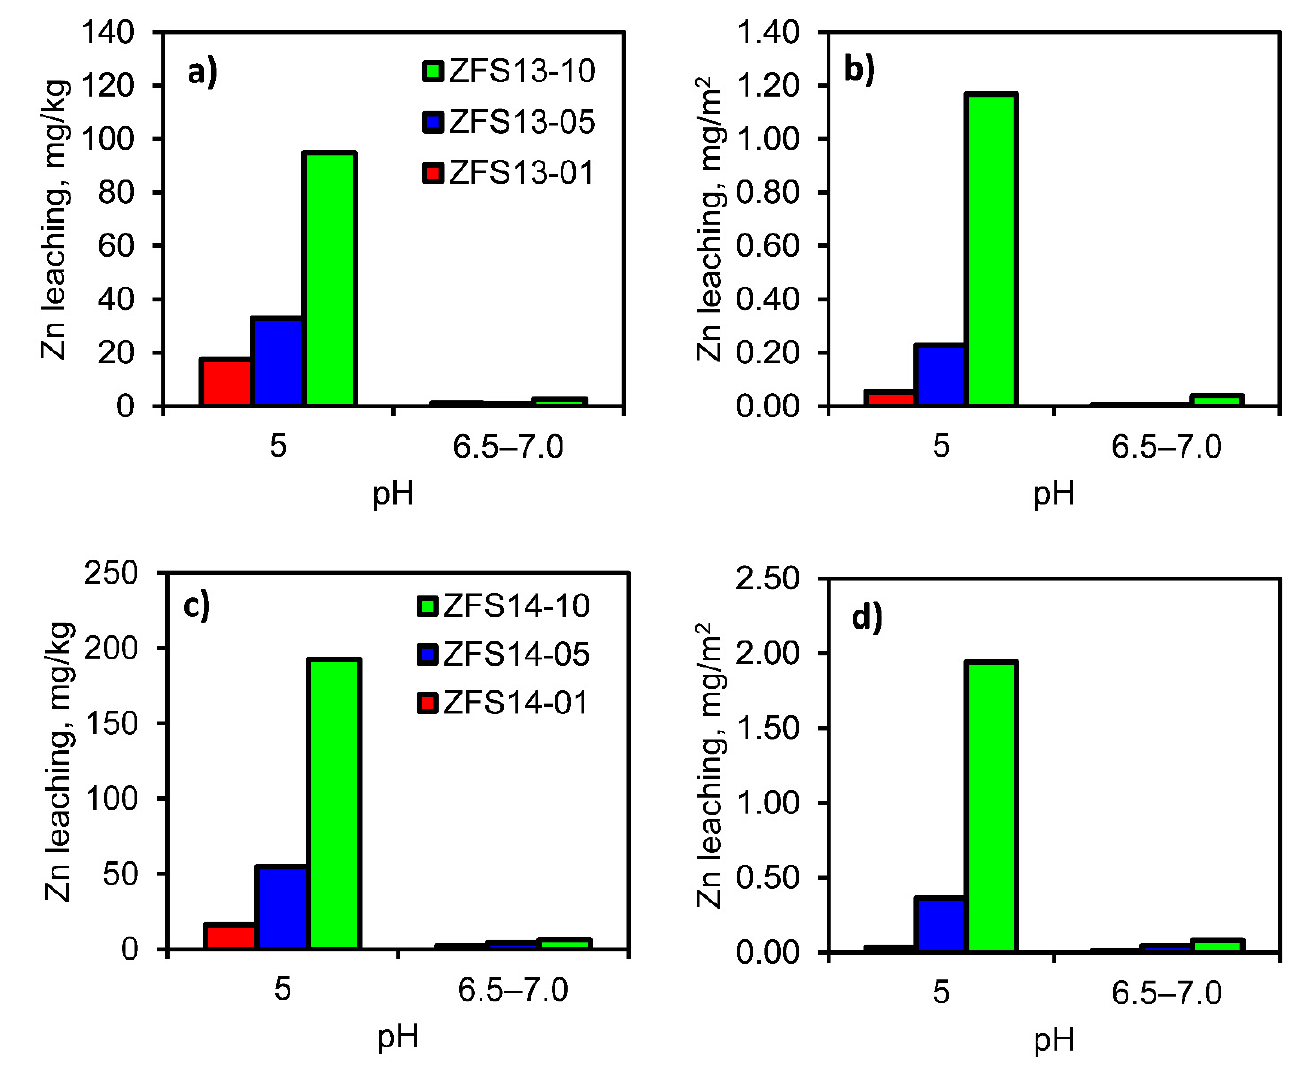
Figure 5. Zn leaching comparison versus pH for ZFS13, in ( a ) mg/kg and ( b ) mg/m 2 , and for ZFS14, in ( c ) mg/kg and ( d ) mg/m 2 .